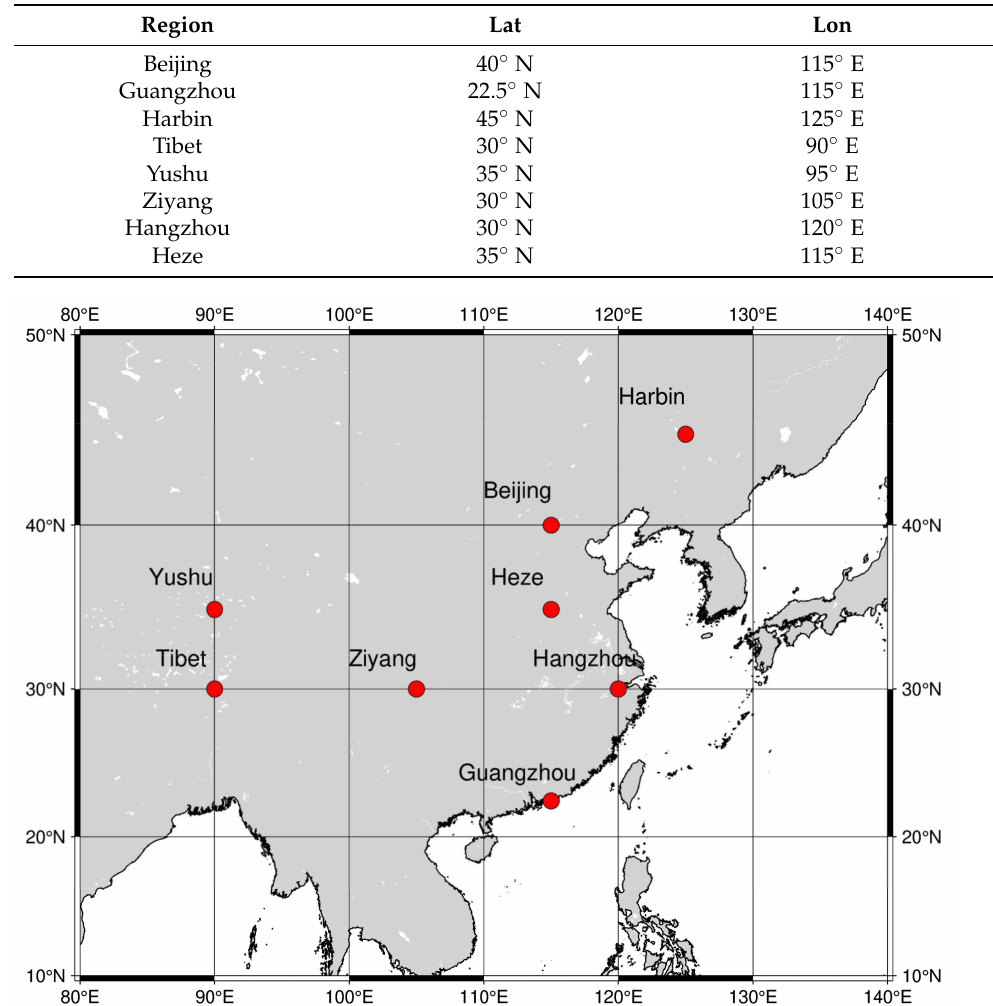
Table 1. The coordinates of the research areas in this paper.